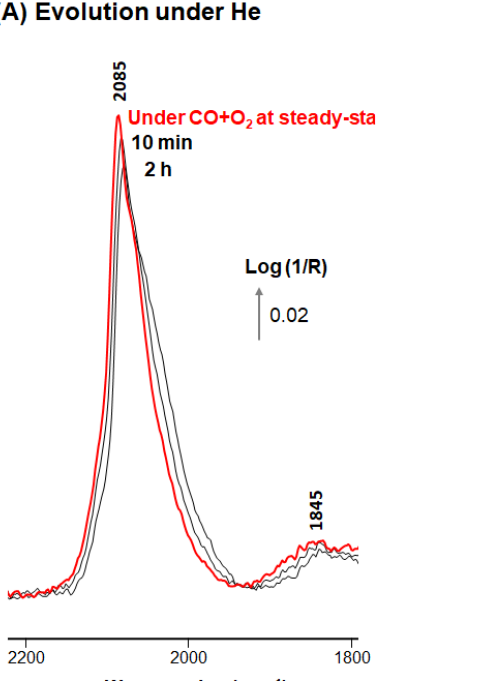
Figure 4. Evolution of DRIFTS spectra over Pt/Al 2 O 3 , recorded at 30 °C as a function of time under ( A ) He and ( B ) 10% O 2 /He. Total flow rate: 100 mL/min. The sample was previously left 15 min